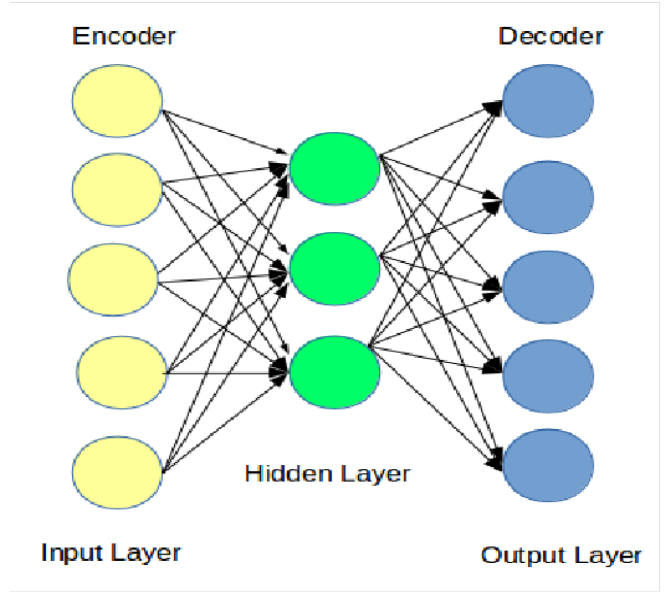
Figure 4. The auto-encoder